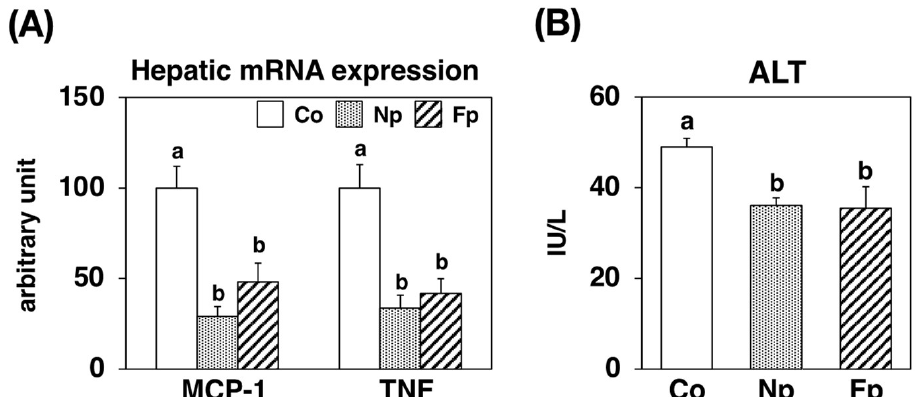
Figure 6. mRNA expression levels of genes related to inflammation in the liver and the hepatic injury marker levels in db / db mice fed a basal diet (Co group), 10% NP-supplemented diet (Np group), or 10% FNP-supplemented diet (Fp group) for 4 weeks. Values are expressed as the mean ± standard error ( n = 5–6). ab Different letters denote significant differences ( p < 0.05) among the three groups. MCP-1: monocyte chemoattractant protein-1, TNF: tumor necrosis factor, ALT: alanine aminotransferase.